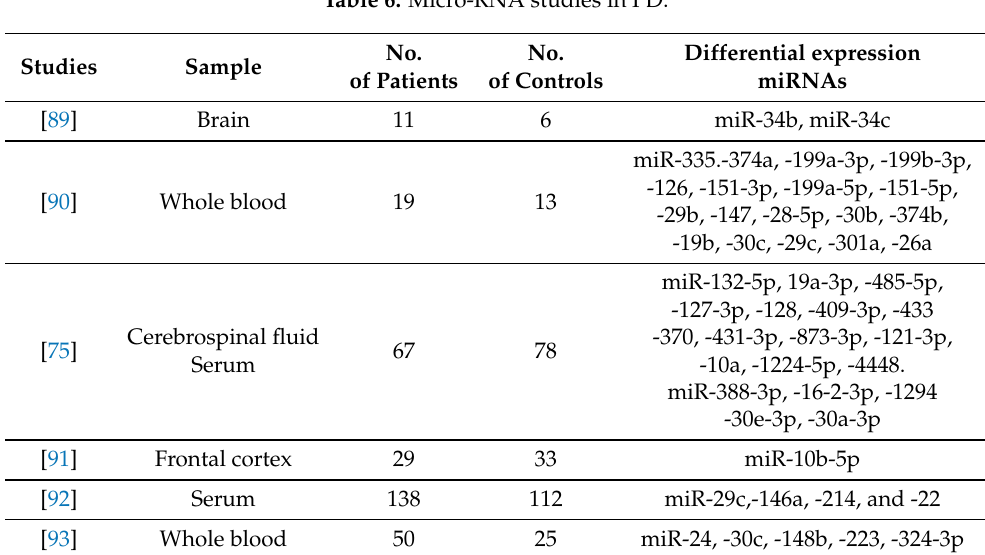
Figure 2. Functional enrichment of reported common miRNAs in AD and PD. Here, color represents the p -value of the pathway, size represents common gene targets of the pathway and miRNAs, and the x -axis represents the number of related miRNAs in that pathway. Table 6. Micro-RNA studies in